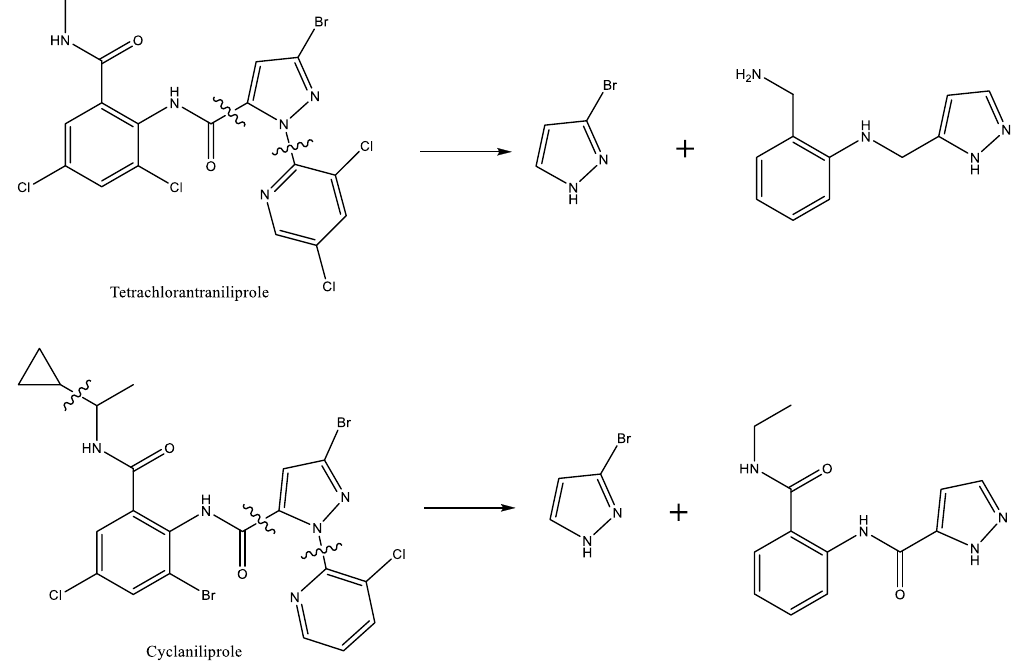
Figure 2. Tetrachlorantraniliprole and cyclaniliprole broken in negative mode.